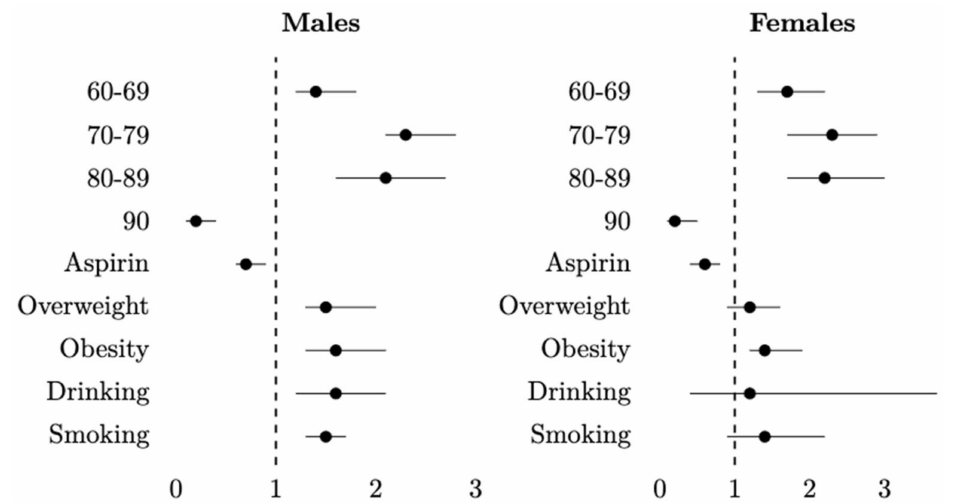
Figure 4. Hazard ratios by Cox regression stratified by males and females. Adjusted for age, aspirin use, BMI, risky drinking and tobacco